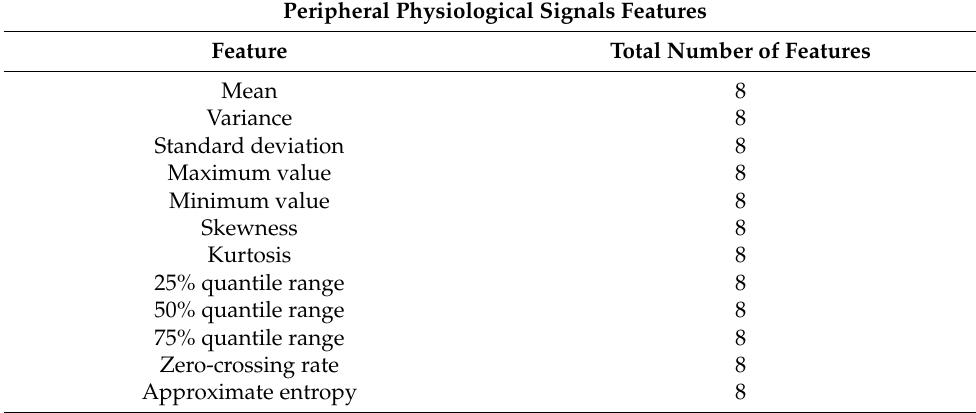
Table 1. Features computed along with their total number for each time window. The features of the peripheral physiological signals were computed once for each one of the 8 different